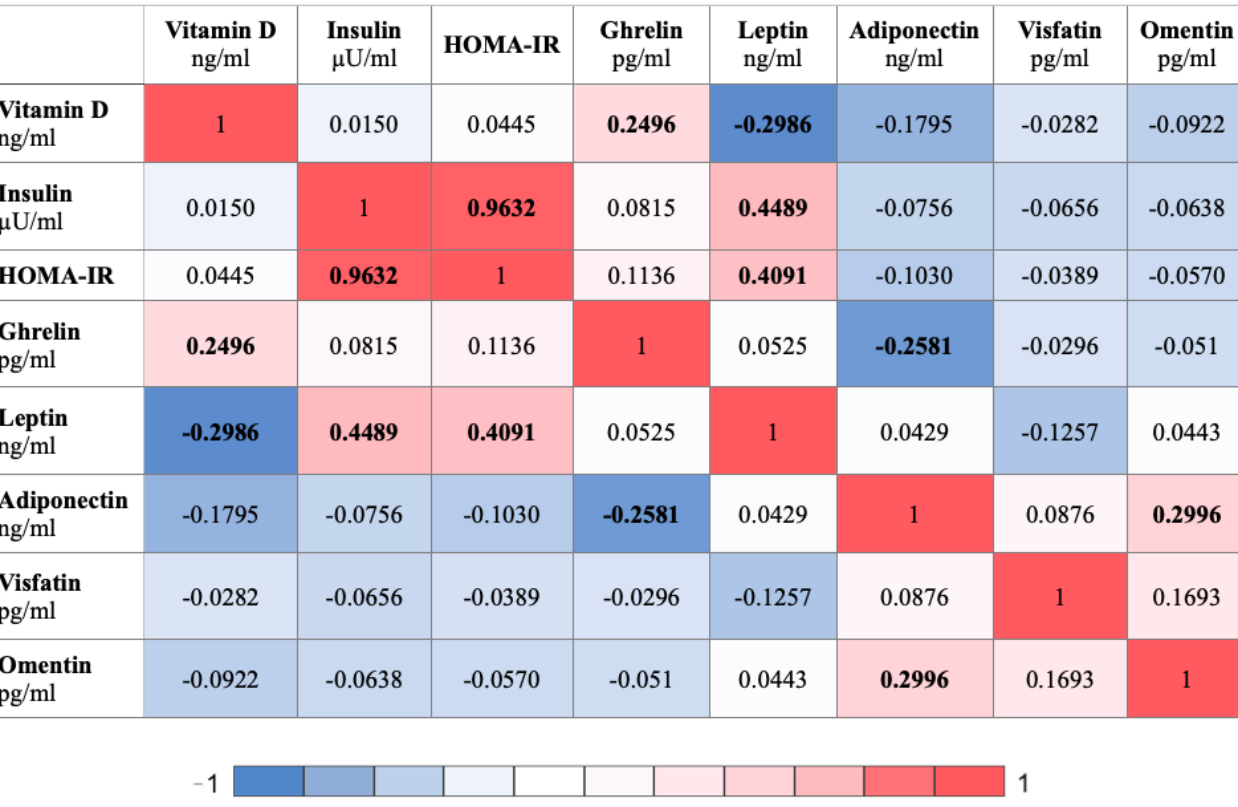
Figure 3. Heatmap displaying the r values obtained from Spearman correlation analysis performed among clinical variables; p -values < 0.05 were considered to indicate statistical significance and are marked in bold. HOMA-IR, Homeostatic Model Assessment—Insulin Resistance.